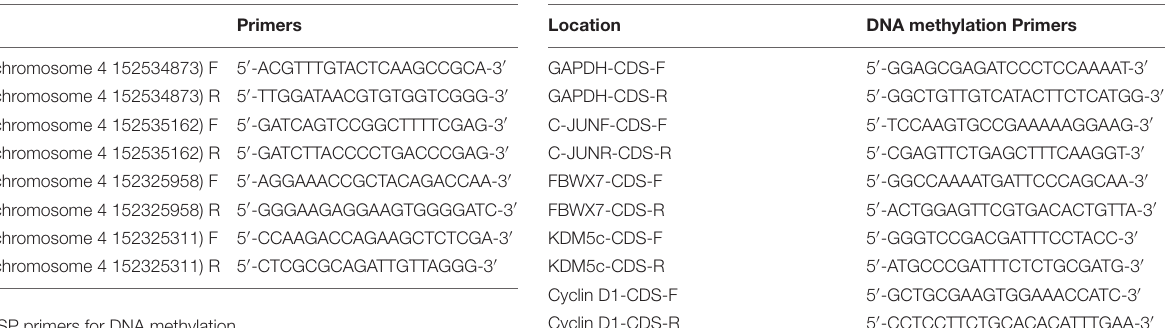
TABLE 3 | BSP primers for DNA methylation. Location DNA methylation Primers